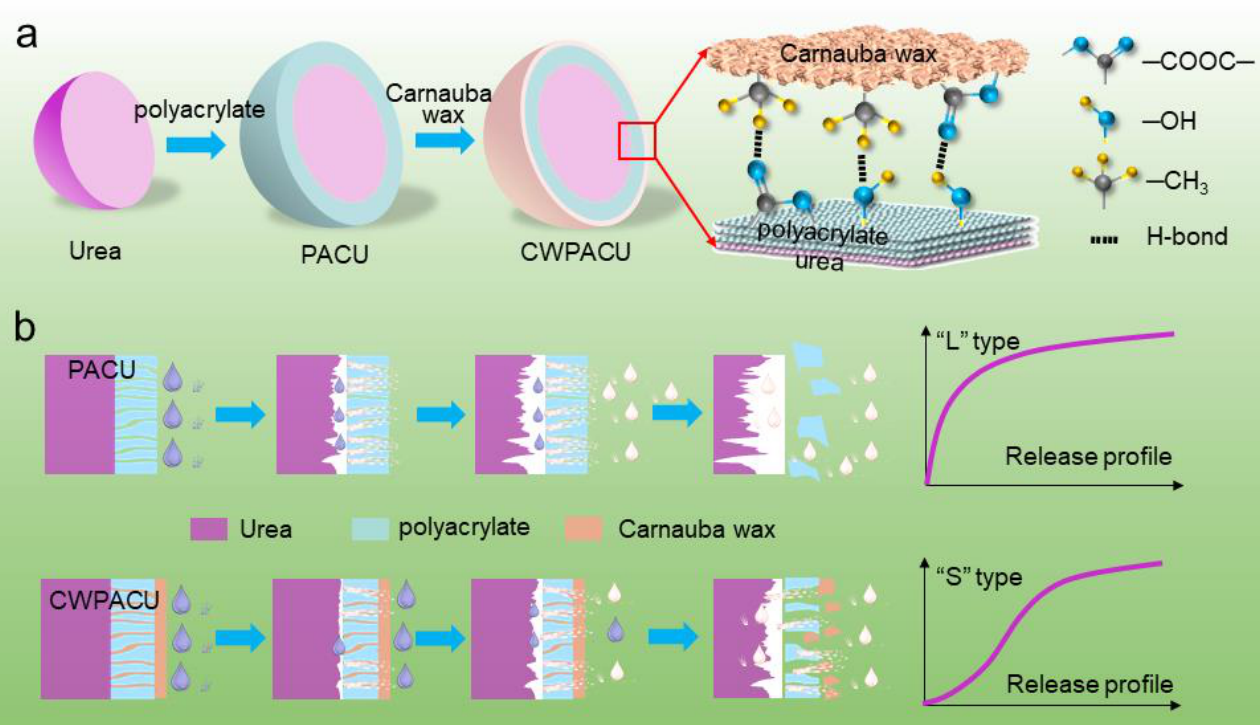
Figure 8. ( a ) Process of Carnauba wax (CW) biomimetic modification of PACU and film formation mechanism of CWPACU. ( b ) Release mechanism of the PACU and CWPACU.